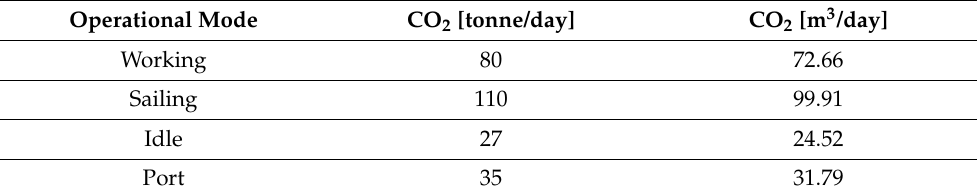
Table 2. Predicted daily amount of storage needed at a 96 MW crane vessel for different operational conditions (Heerema